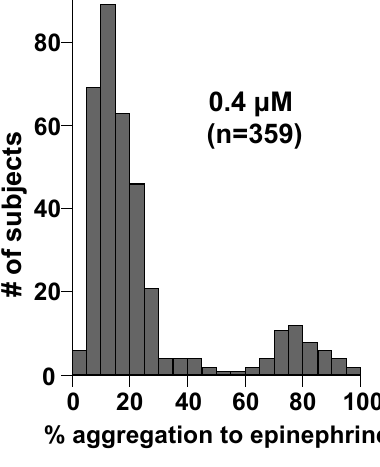
FIGURE 3. Range of aggregation response to epinephrine among healthy individuals. Histogram displaying broad range of platelet aggregation response to 0.4 μ M/l epinephrine. Use of this low, “submaximal” epinephrine concentration highlights a minority of subjects who demonstrate a